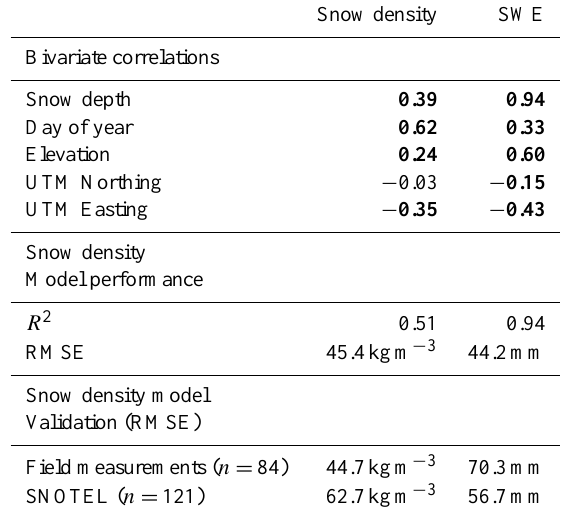
Table 1. Historic snow course bivariate correlations between snow density, SWE, snow depth, Julian day, elevation, UTM Northing, and UTM Easting and snow density model calibration and valida- tion performance statistics. Performance statistics for snow water equivalent based on using modeled snow density and observed snow depth to calculate SWE. Bolded values represent statistical signifi- cance ( p value<0.05). Snow density SWE Bivariate correlations